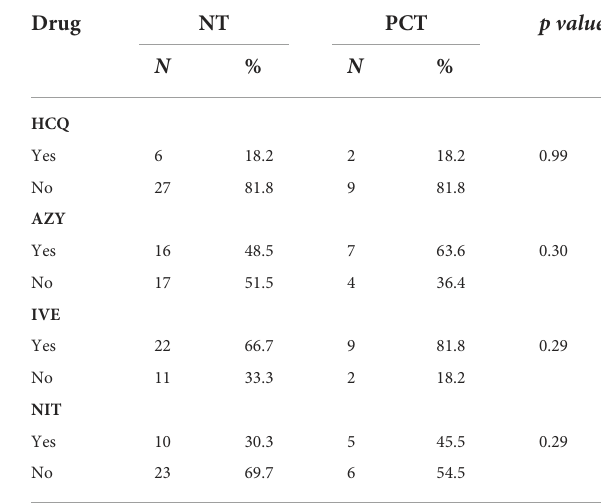
TABLE 4 The comparison of their use between the